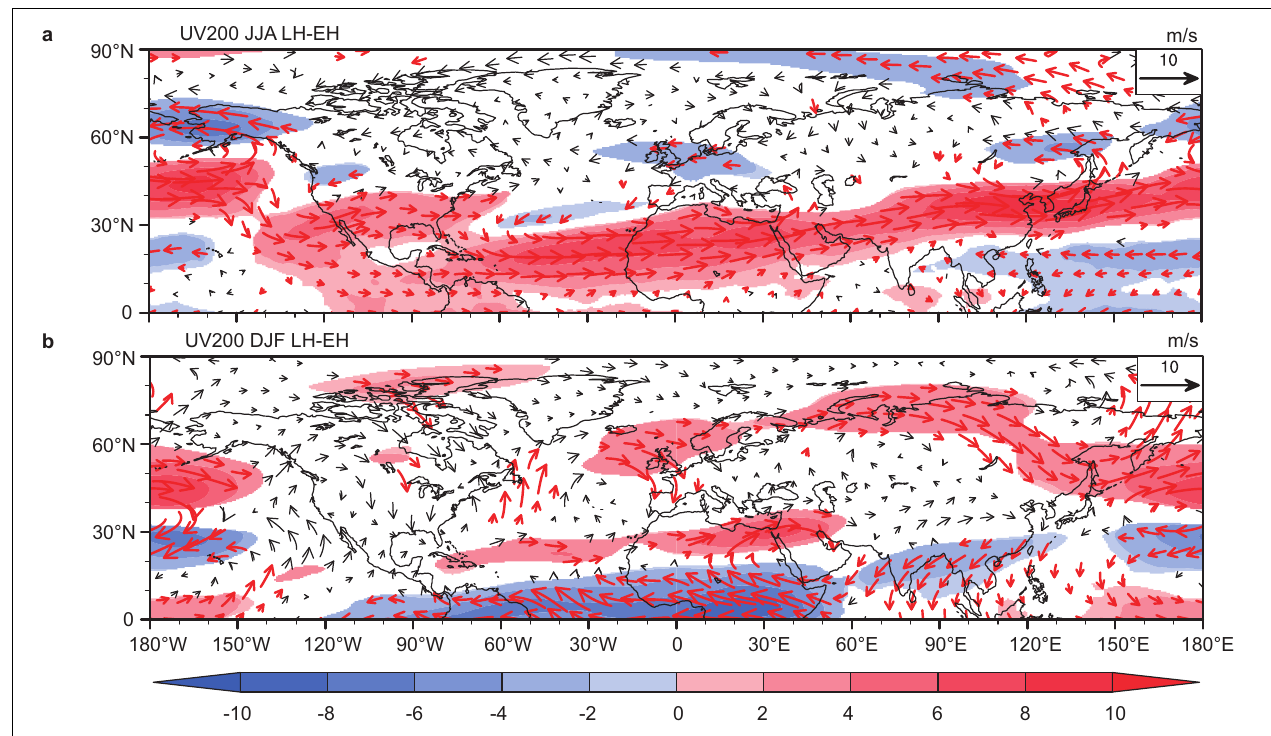
FIGURE 4 | The differences in 200 hPa wind field (m/s) between late Holocene and early Holocene in summer (a) and winter (b) . Red vectors indicate that the differences are significant at the 95% confidence level and the shading represents the differences in 200 hPa westerly winds are significant.